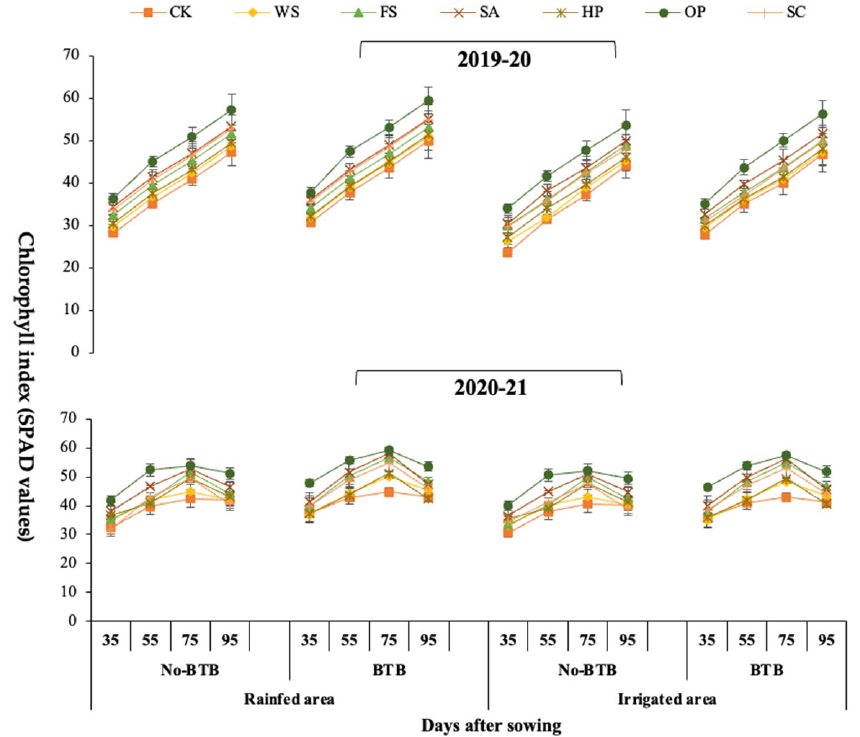
Figure 1. The impact of different boron application methods and boron ‐ tolerant bacteria ( Bacillus sp. MN54) on chlorophyll index (SPAD value) of desi chickpea grown under rainfed and irrigated conditions. Here: CK = control; WS = water spray; FS = foliar spray of B; SA = soil application of B; HP = hydropriming; OP = osmopriming of B; SC = seed coating of B; and BTB = boron ‐ tolerant bac ‐ teria.